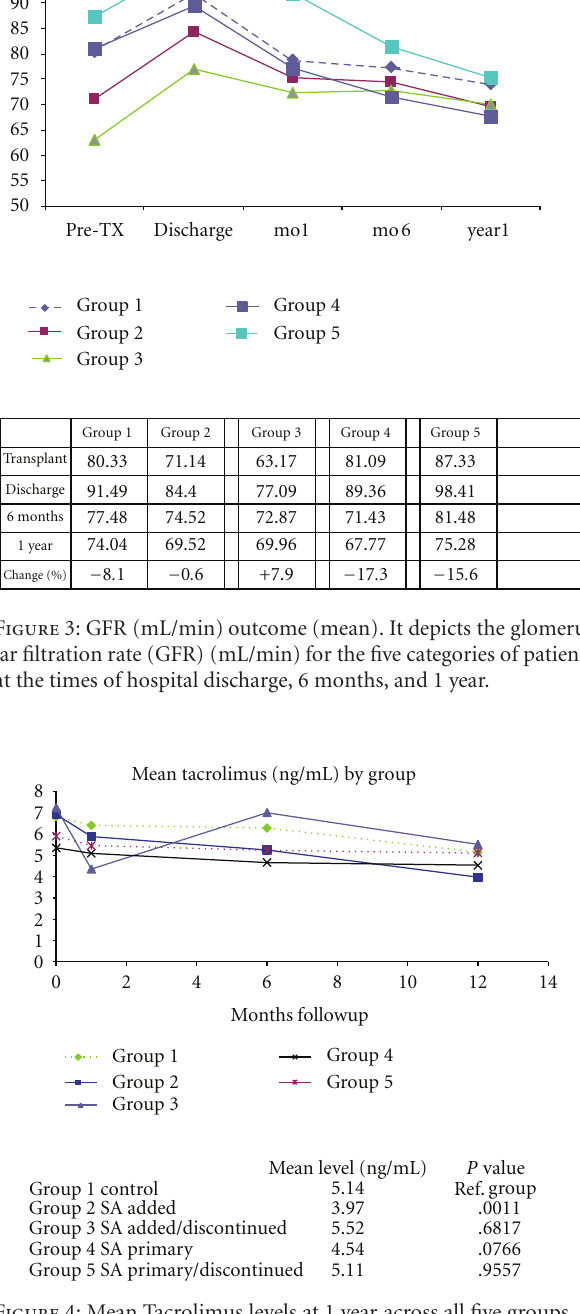
Figure 4: Mean Tacrolimus levels at 1 year across all five groups. It depicts mean Tacrolimus levels across all groups at 1